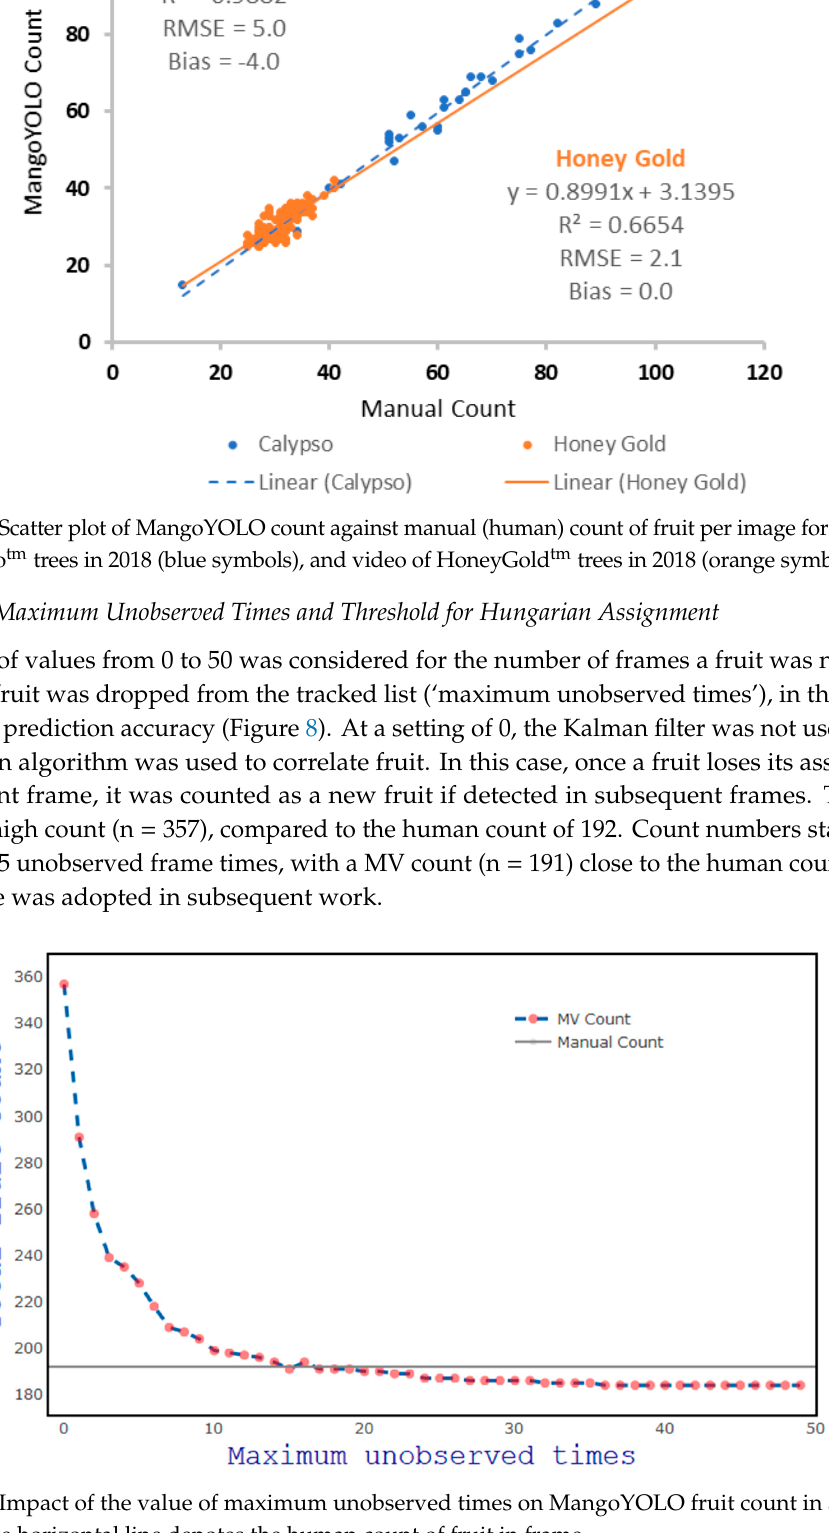
Figure 8. Impact of the value of maximum unobserved times on MangoYOLO fruit count in a video frame. The horizontal line denotes the human count of fruit in frame. The horizontal line denotes the human count of fruit in frame.